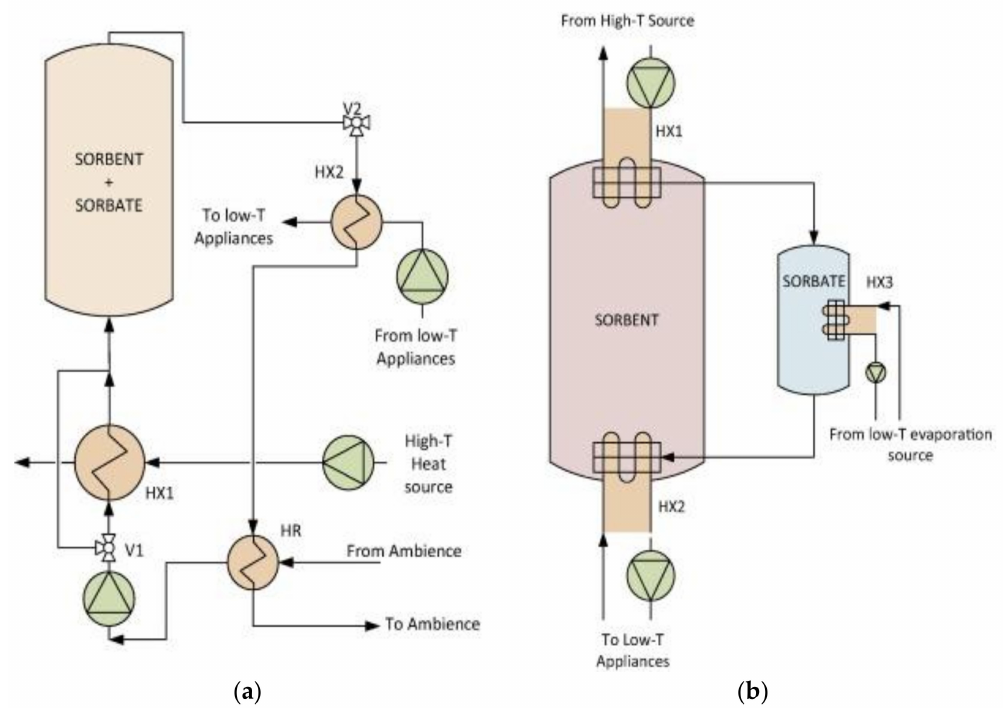
Figure 16. Sorption heat storage systems for long-term [128]: ( a ) Open sorption system; ( b ) Closed sorption system.